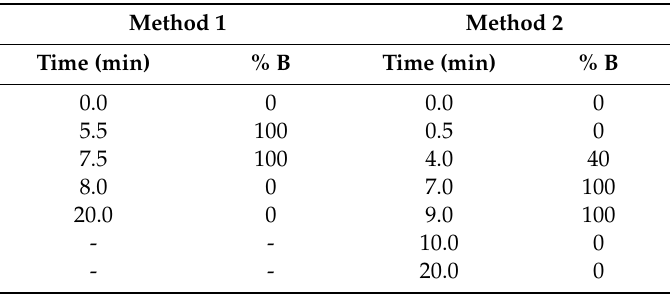
Table A1. Elution methods used in antibiotic quantification. Gradient elution of 0.1% formic acid in water and methanol (% B) with respect to time (min) that separated sulfonamides, macrolides, and others via method 1 and fluoroquinolones and tetracyclines via method 2 on a Waters XSelect CSH C18 column for ASE